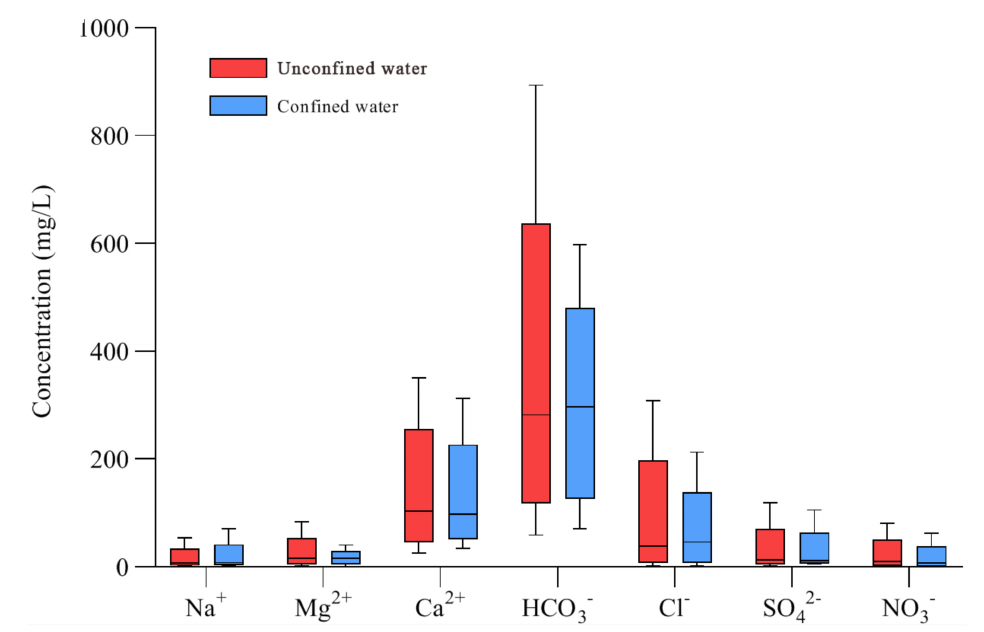
Figure 2. Box diagram of physical and chemical parameters of unconfined water and confined